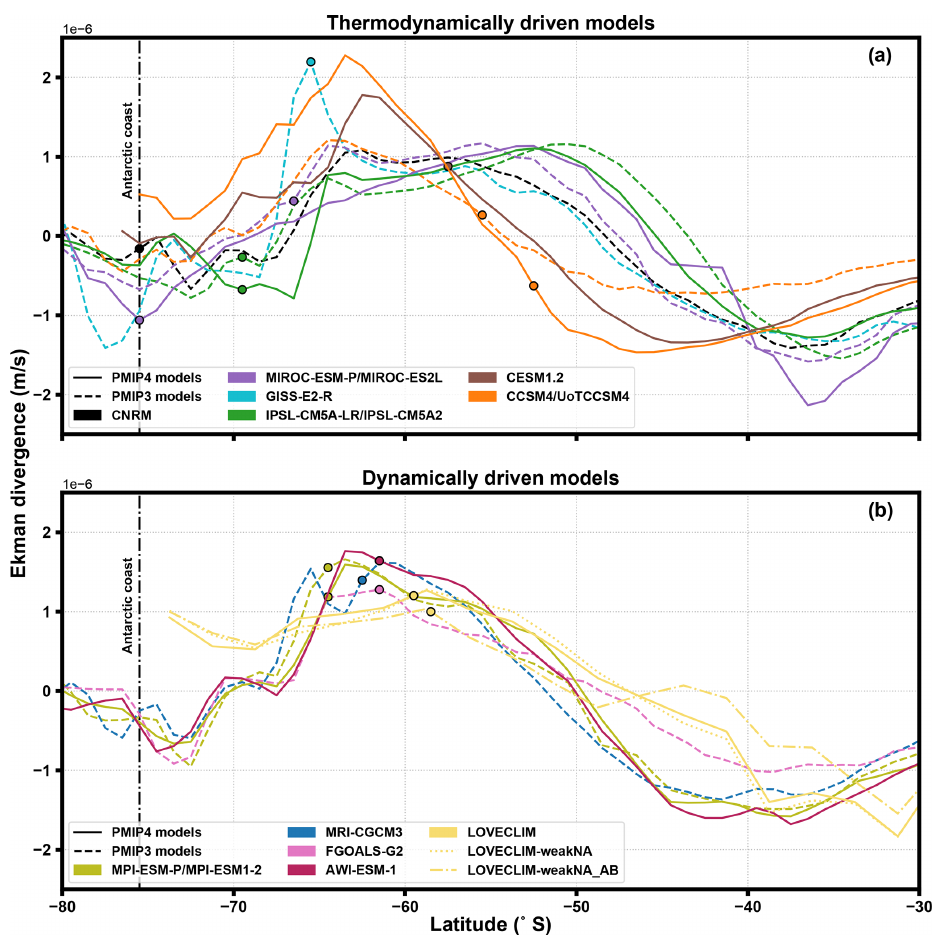
Figure 4. Zonally averaged austral summer Ekman divergence vs. latitude for (a) models in which mean temperature controls the summer sea-ice edge, (b) models in which Southern Ocean upwelling, and associated divergence, impacts the summer sea-ice edge. Each model’s sea-ice edge is represented with a filled